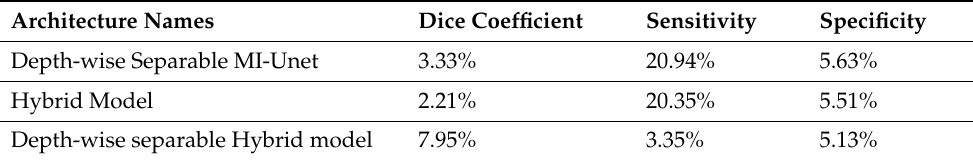
Table 4. Percentage Increase In Performance With Comparison to MI-Unet Architecture.